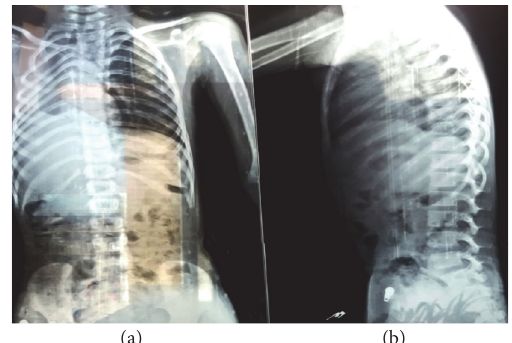
Figure 3: (a) X-ray showing dextrocardia, crowding of right-sided ribs, and tracheal shift to right side; (b) showing normal